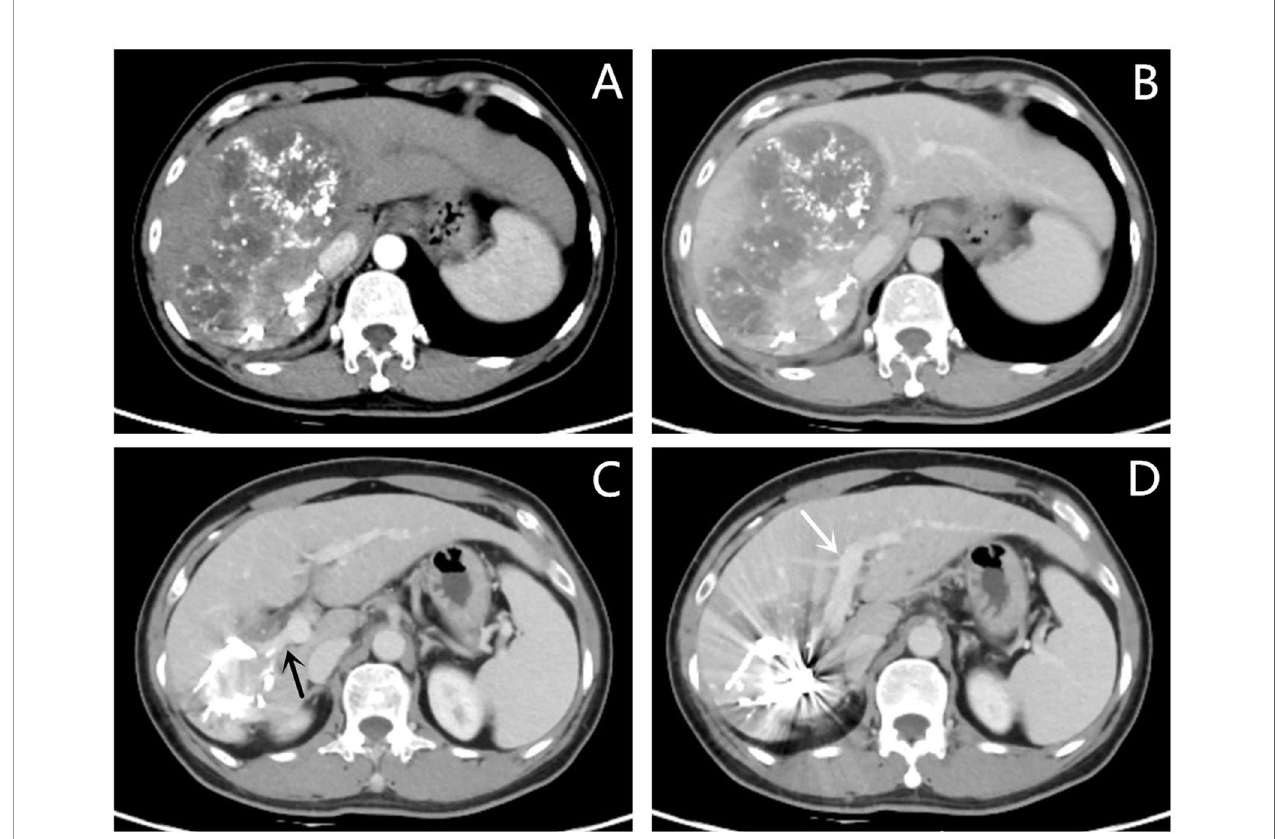
FIGURE 5 | Images of follow-up contrast-enhanced CT of the same patient as in Figures 1 , 2 after PVE and three sessions of transarterial chemoembolization. (A, B) Hepatic arterial phase (A) and portal vein phase (B) showing that the lesion is fully necrotic. (C) Images of the portal vein phase showing a clear initial part of the right portal vein (black arrow). (D) Images of the portal vein phase showing a clear left portal vein (white arrow). Compared with Figure 1 , the left lobe of the liver proliferated signi fi cantly after